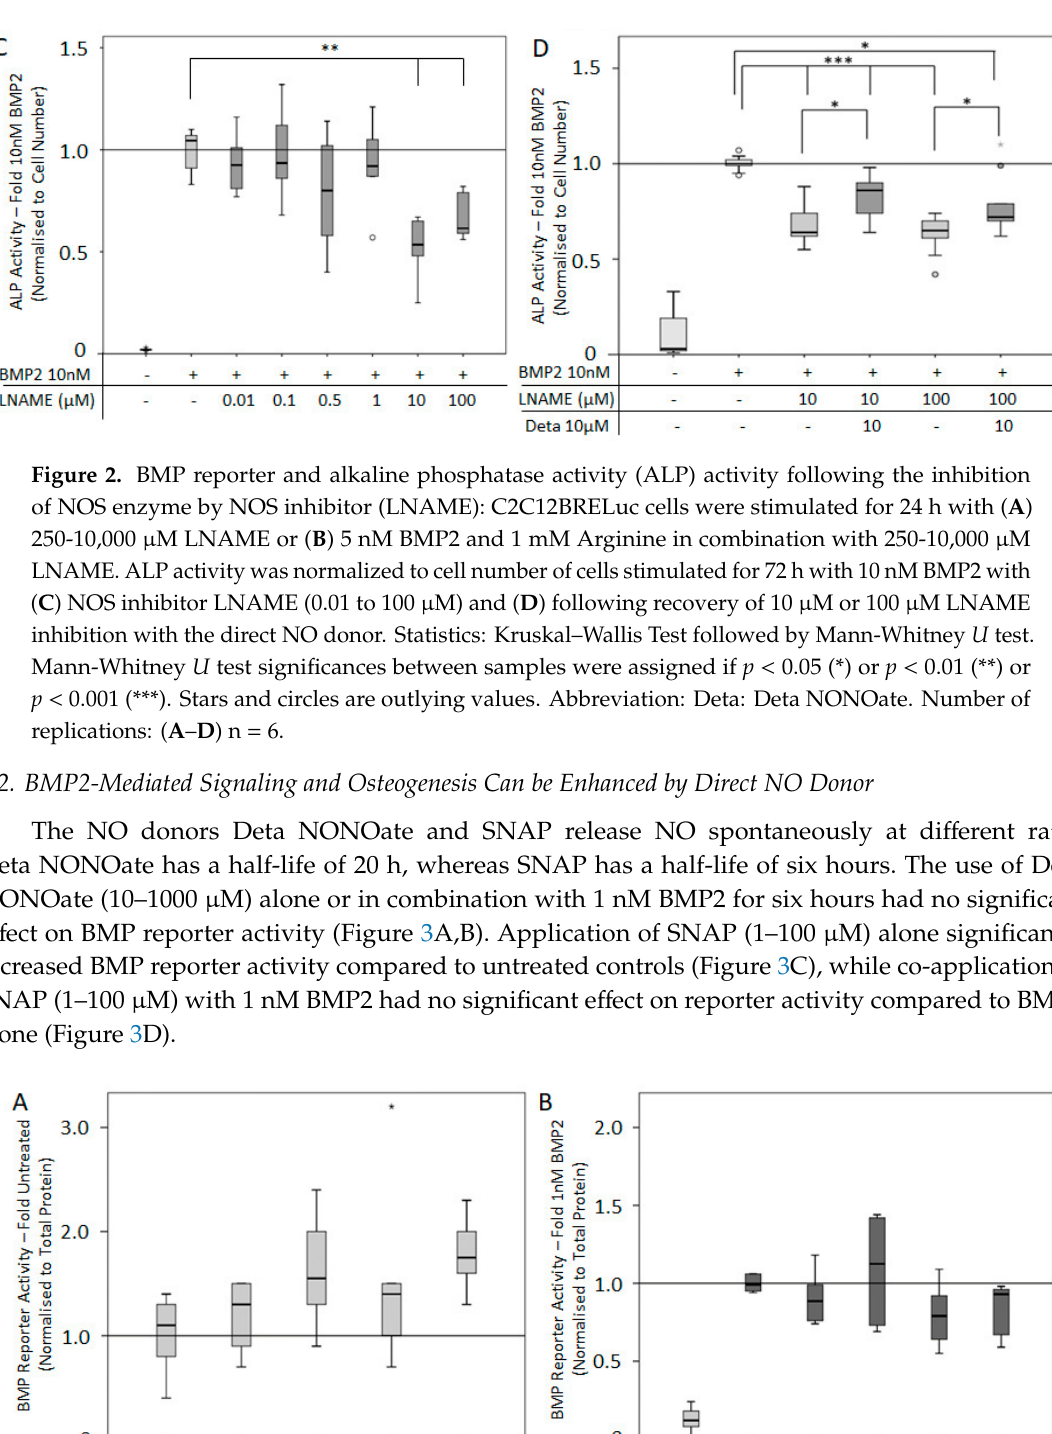
Figure 3. BMP reporter activity after stimulation with the NO donors Deta NONOate and SNAP for six hours: C2C12BRELuc cell were stimulated in Arginine-free DMEM with ( A ) 10–1000 μ M Deta NONOate or ( B ) in combination with 1 nM BMP2, with ( C ) 1-100 μ M SNAP or ( D ) SNAP in combination with 1 nM BMP2. Statistics: Kruskal–Wallis Test followed by Mann-Whitney U test. Mann-Whitney U test significances between samples were assigned if p < 0.05 (*) or p < 0.01 (**). Abbreviations: Deta = Deta NONOate. Stars and circles are outlying values. Number of replications ( A – B ) n = 6; ( C ) n = 18; ( D ) n = 9. Due to the fact that no effect was observed after six hours, the experiment was repeated with a stimulation period of 24 h. For this 24 h timepoint, Deta NONOate alone (1–100 μ M) stimulated BMP reporter activity (Figure 4A). The combined use of Deta NONOate (1–100 μ M) and 1 nM BMP2 significantly increased BMP reporter activity compared to BMP2 alone in a dose-dependent manner (Figure 4B). Interestingly, in Arginine-containing media, a lower dose of Deta NONOate (1 and 10 μ M) with 1 nM BMP2 had an additional effect on the cells, while a high concentration of Deta NONOate (100 μ M) and 1nM BMP2 was inhibitory (Figure 4C). The combination of SNAP (5–50 μ M) with 1 nM BMP2 had no effect on reporter activity compared to BMP2 alone (Figure 4D).